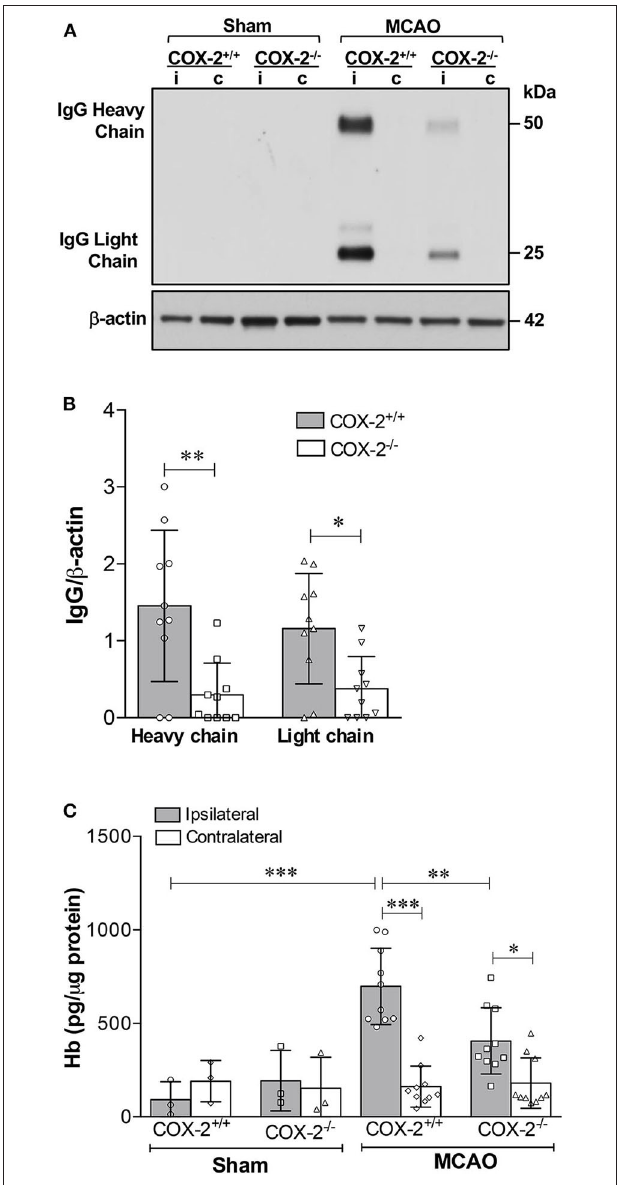
FIGURE 1 | COX-2 genetic inactivation protects against stroke-induced BBB breakdown and hemorrhagic transformation. BBB permeability was assessed by immunoglobulin G (IgG) extravasation into the brain, as quantified by immunoblotting. (A) Representative western blot for IgG (heavy and light chains) in the cerebral cortex of wild-type (COX-2 + / + ) and knockout (COX-2 − / − ) mice; i, ipsilateral; c, contralateral. There is a significant reduction in BBB damage in COX-2 − / − mice compared to wild-type controls at 24h following 60min of temporary middle cerebral artery occlusion (MCAO). (B) Densitometric analysis of heavy and light chains of IgG normalized to β -actin in the ischemic cortex of mice of both genotypes. Unpaired t -test, * P < 0.05 and ** P < 0.01. (C) Hemoglobin (Hb) levels in the brains were quantified using a highly sensitive ELISA as a measure of hemorrhagic transformation following ischemia. COX-2 − / − mice had a significant reduction in Hb levels after stroke compared to COX-2 + / + controls. Two-way ANOVA with Bonferroni post-tests. * P < 0.05, ** P < 0.01, and *** P < 0.001. Bars represent mean ± SD. n = 10 in MCAO groups of each genotype. Sham-operated groups ( n =